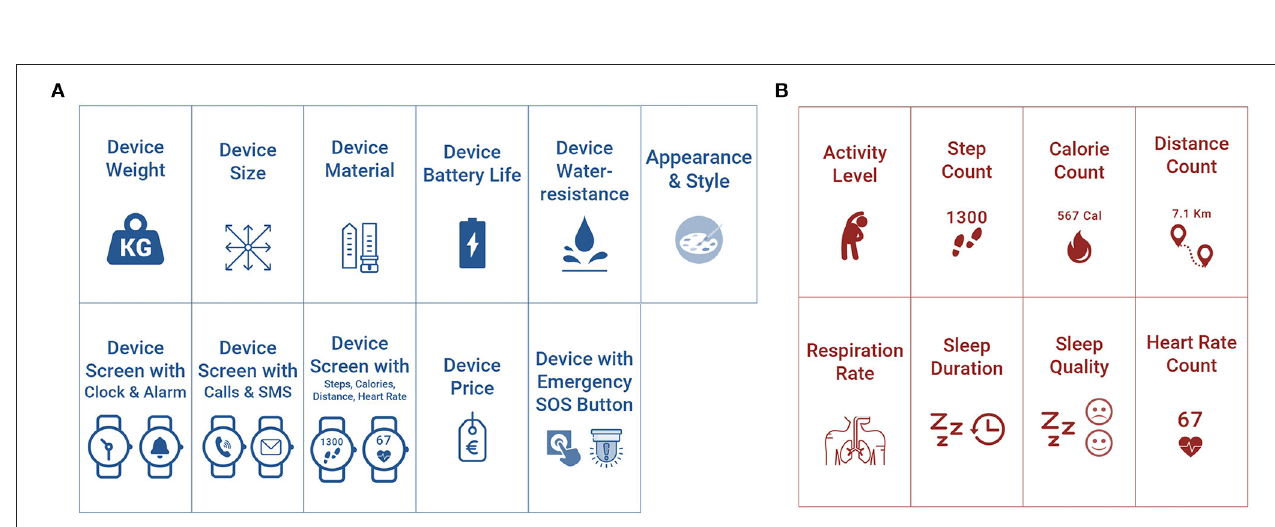
FIGURE 5 | The feature (A) and the metrics (B) card sets.